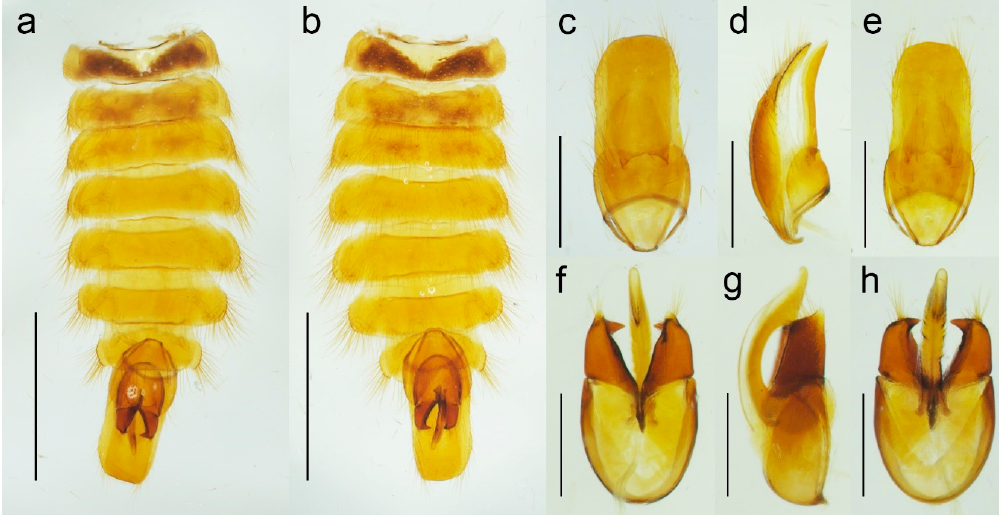
Figure 5. Malacogaster passerinii Bassi, 1834 from Sardinia, Italy (PCRK), male, details of morphology. ( a ) Abdomen, dorsal view; ( b ) abdomen, ventral view; ( c ) genital capsule formed by tergites IX and X, and sternite IX, dorsal view; ( d ) genital capsule formed by tergites IX and X, and sternite IX, lateral view; ( e ) genital capsule formed by tergites IX and X, and sternite IX, ventral view; ( f ) aedeagus, dorsal view; ( g ) aedeagus, lateral view; ( h ) aedeagus, ventral view. Scale bars = ( a , b ) 2.0 mm; ( c – e ) 1.0 mm; ( f – h ) 0.5